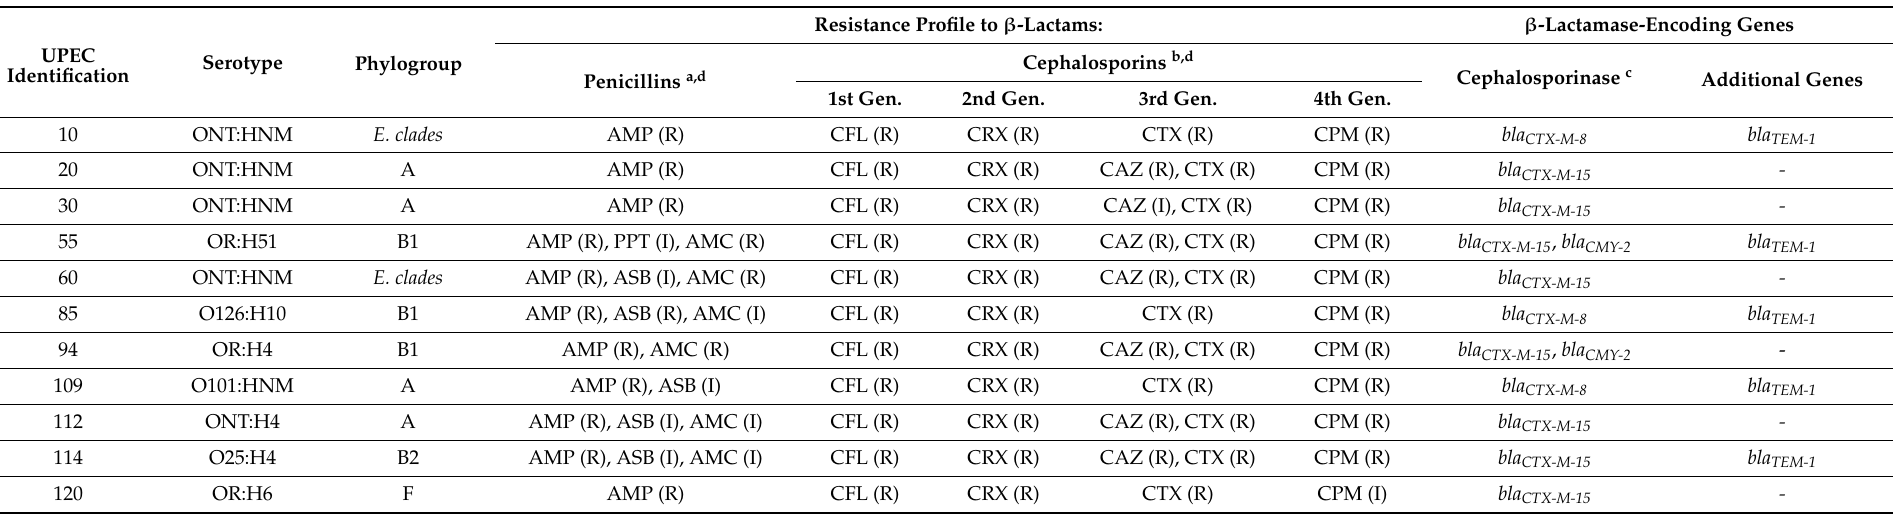
Table 5. Phenotypic and molecular features of the eleven Extended Spectrum Beta-Lactamase (ESBL)-producing uropathogenic E. coli (UPEC) isolates identified in this study.